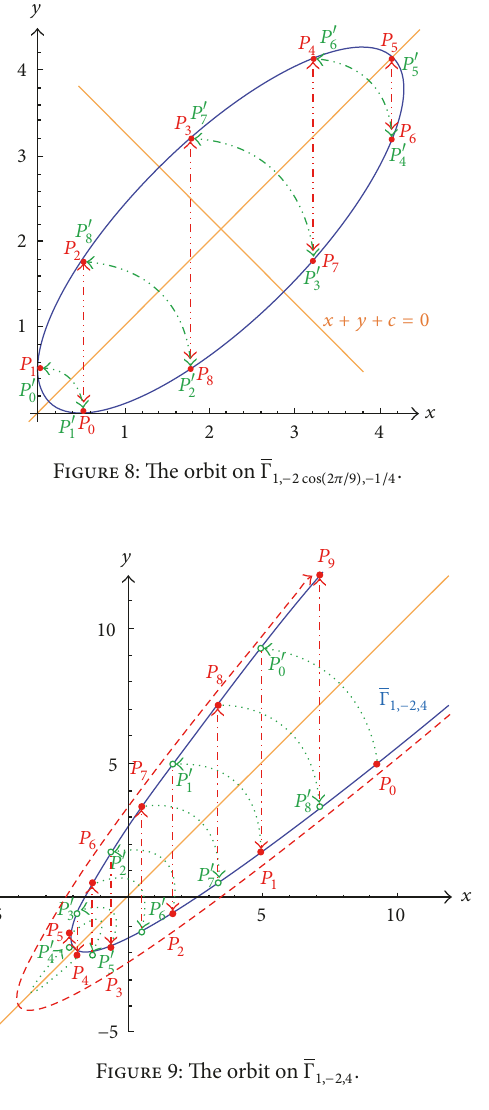
Figure 9: The orbit on Γ 1,−2,4 .